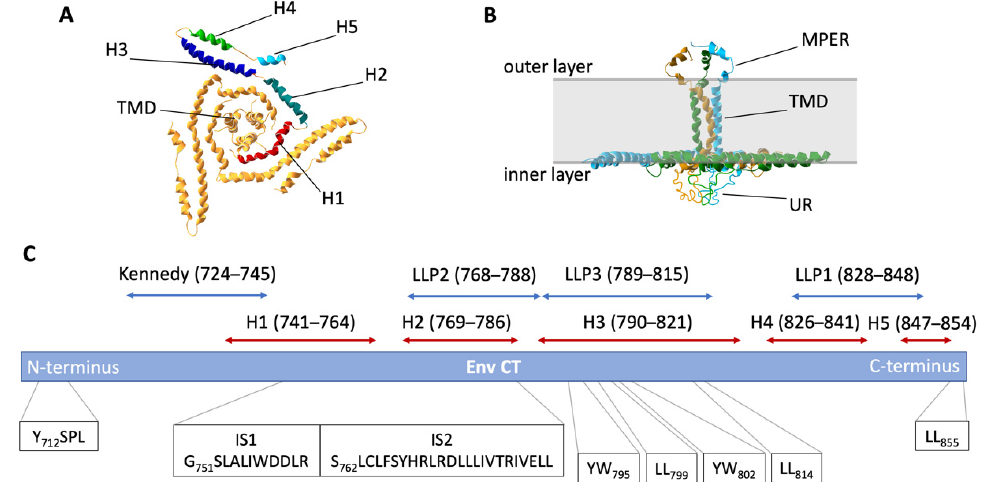
Figure 3. ( A ) A structural model of trimeric CT with colored α helices labeled as H1–H5; from PDB 7LOH [3]. TMD = transmembrane domain. ( B ) Side view of trimeric TMD/CT; from PDB 7LOI [3]. MPER = membrane-proximal ectodomain region; UR = unstructured region. Rendering of structures was performed with Swiss PDB Viewer. ( C ) Linear schematic of Env CT, showing relative positions of domains and motifs discussed in the text. Numbering is based on HXB2.